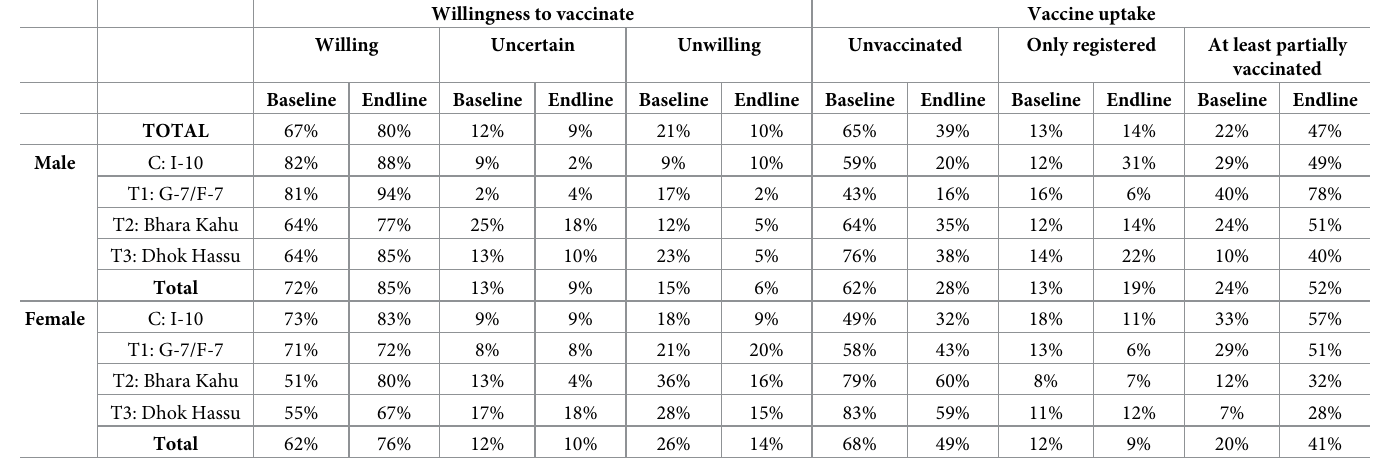
Table 3. Willingness to vaccinate and vaccine uptake segregated by gender and location. Willingness to